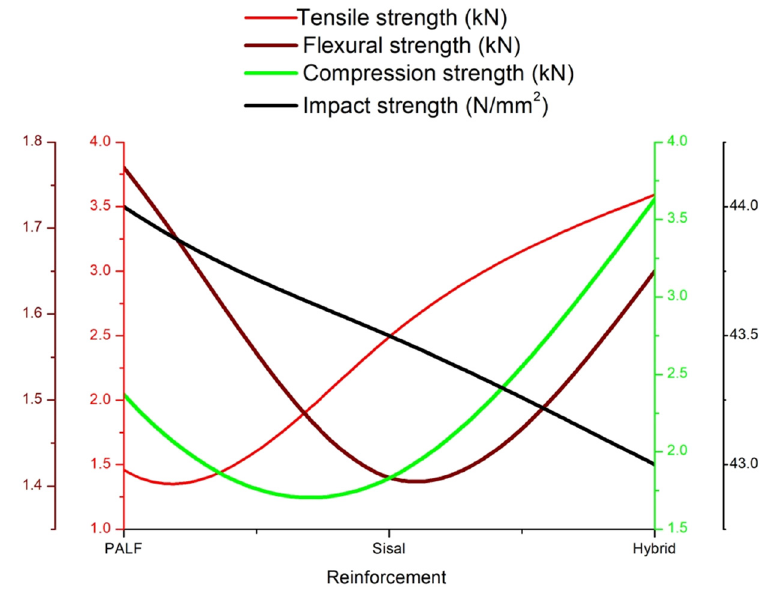
Figure 2: Mechanical strength of the PALF, sisal, and hybrid